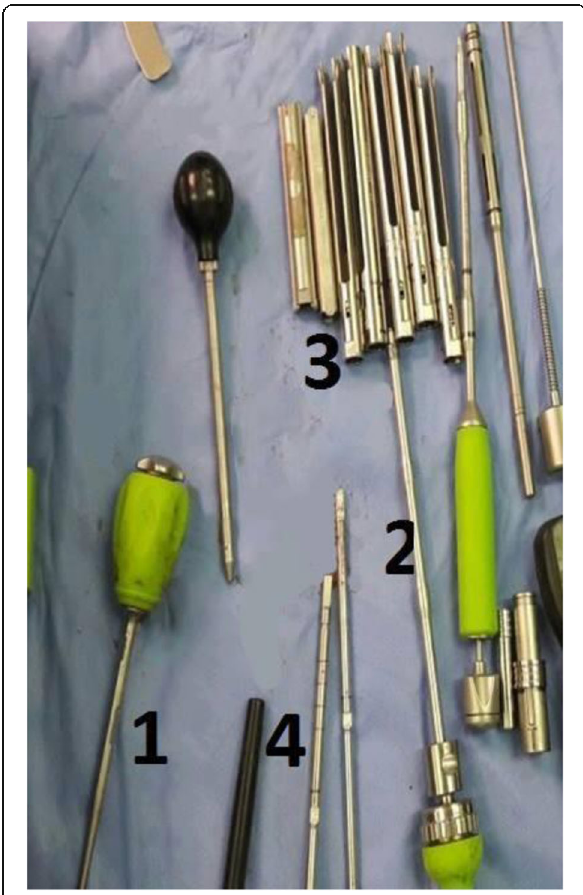
Fig. 1 Tools used: the most important 1. Tap cannula. 2. Self-drilling cannulated tap. 3. Cannulated polyaxial extensions. 4. Dilators